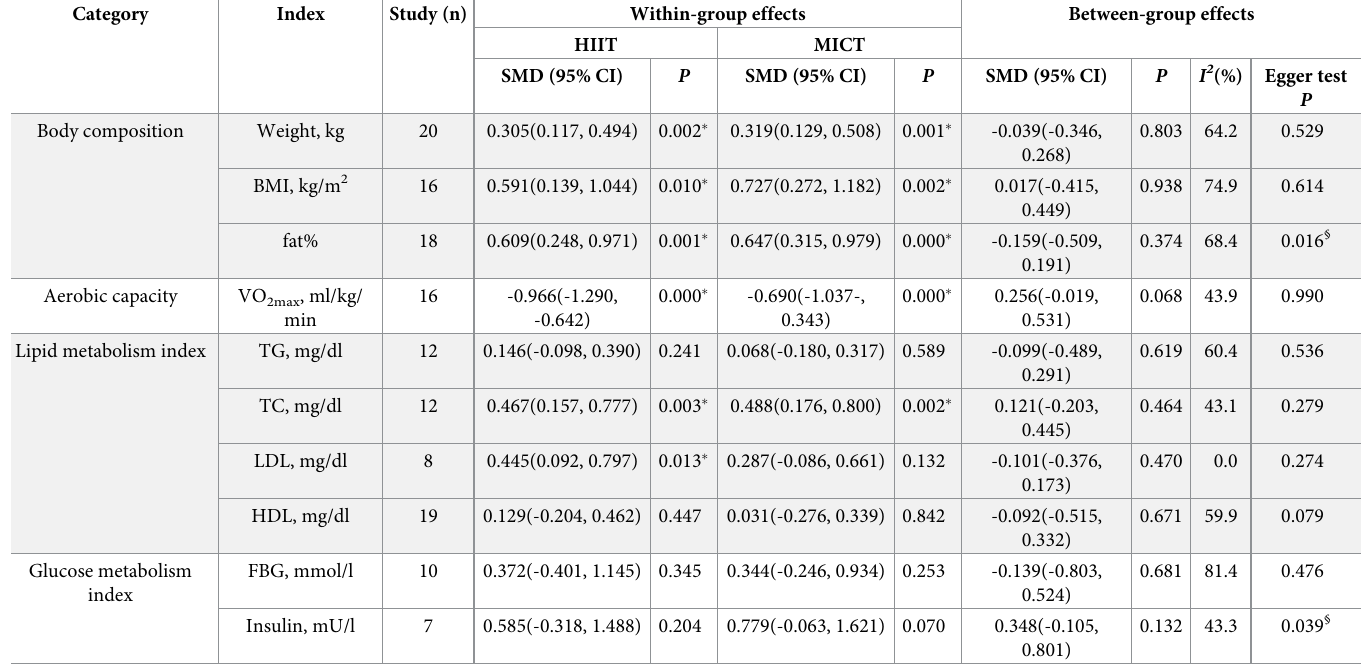
Table 3. Effects of HIIT vs. MICT on body composition, aerobic capacity, lipid metabolism, glucose